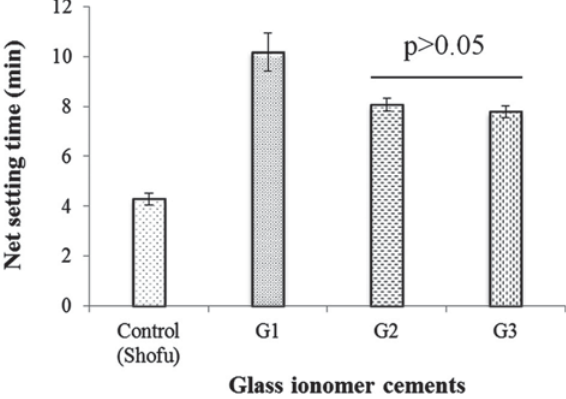
Figure 2- Net setting time of glass ionomer cements.